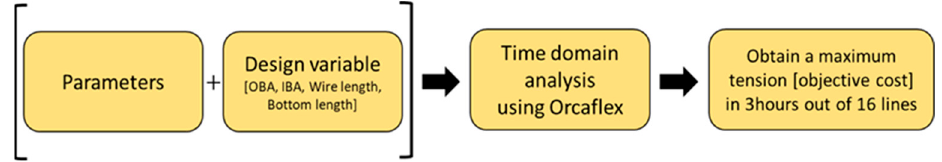
Figure 5. The procedure to obtain the maximum tension that is the objective cost.